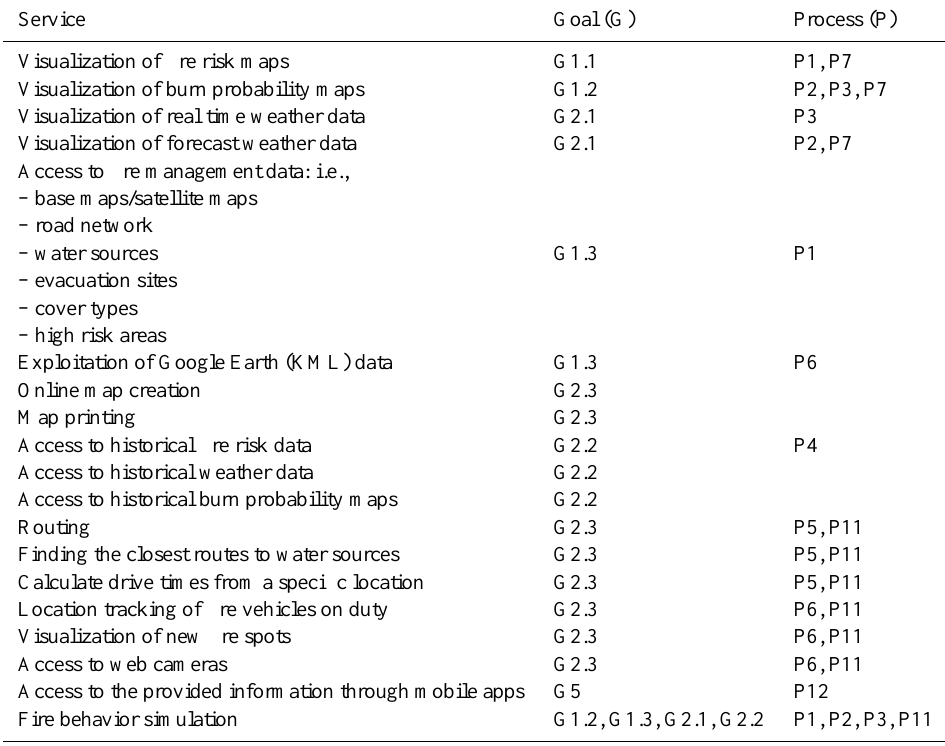
Table 2. Proposed services, goals and corresponding processes in the AEGIS platform. Service Goal (G)